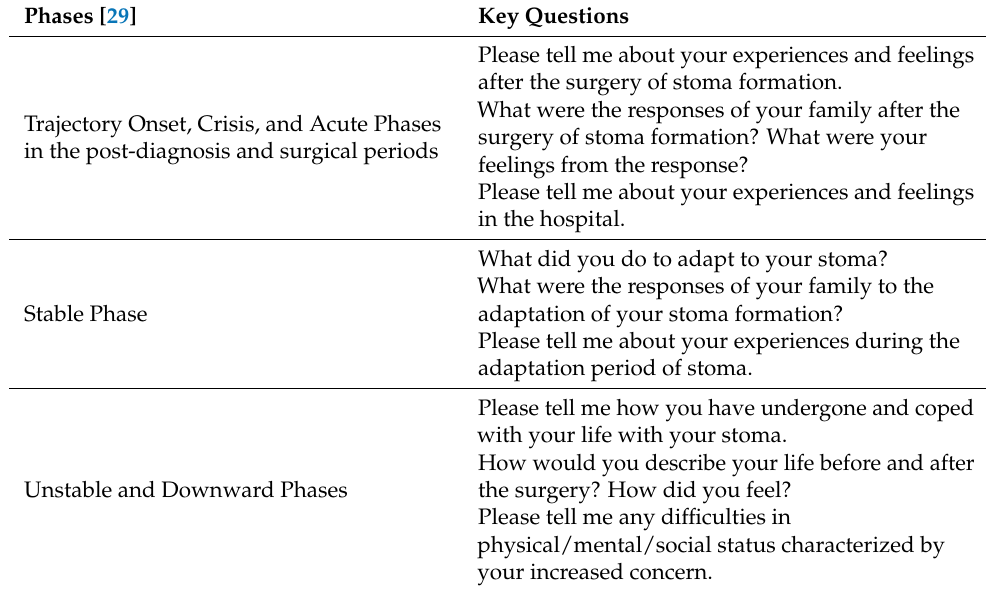
Table 1. Focus group interview